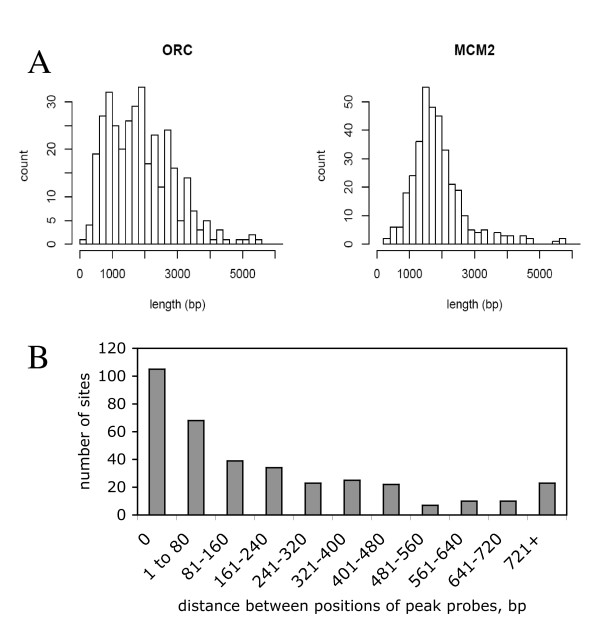
Comparison of ORC and MCM2 data within the set of ORC-MCM2 sites. A. Length of the ORC and MCM2 HMM-called regions is shown. B. Distance between the positions of probes that define ORC and MCM2 peaks in the ORC-MCM2 class of binding sites. Thus "0" means that the peaks identified are the same 50 bp probe and "721+" means that the peaks are more than 9 probes (spaced ~80 bp) apart.